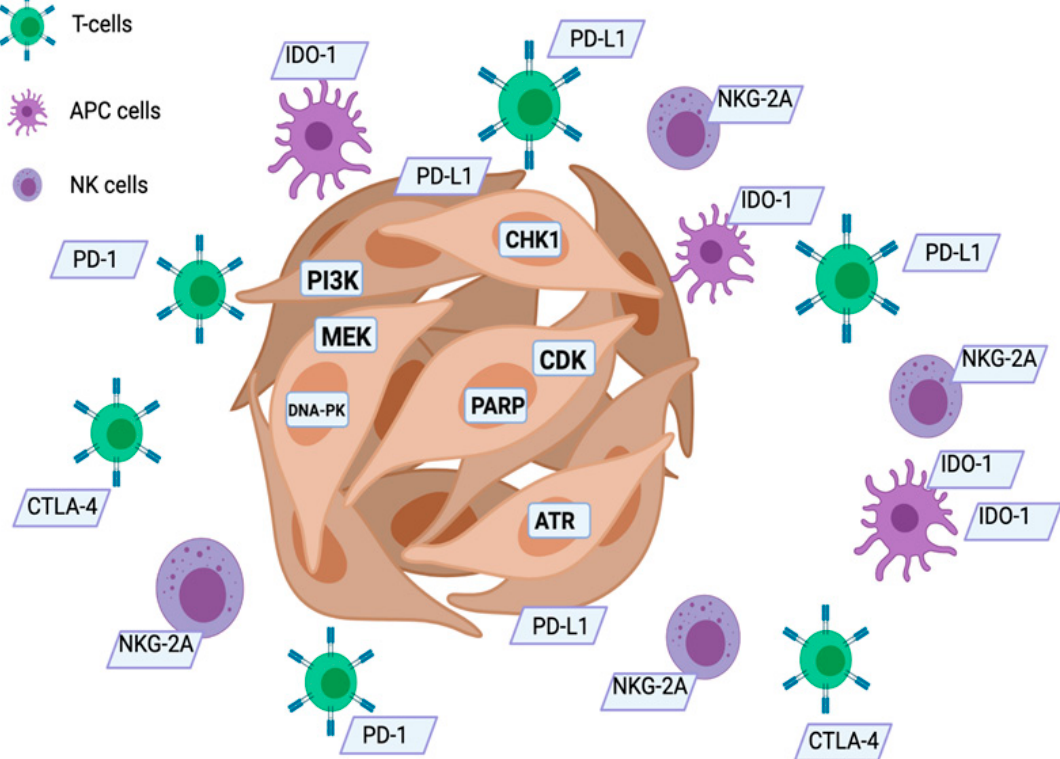
Figure 1. New possible targets in HNSCC. APC: antigen presenting cells; NK: natural killer cells; PARP: poly (ADP-ribose) polymerase; IDO-1: indoleamine 2,3-dioxygenase; ATR: ataxia telangiectasia and Rad3-related protein. Table 1. Drugs employed in HNSCC. Drug Category Status Targeted Therapy Cetuximab APPROVED (anti-EGFR) Targeted Therapy experimental (anti-EGFR)